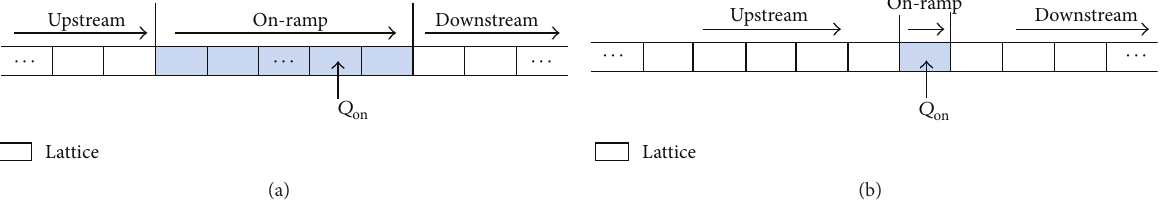
Figure 3: The sketches of the on-ramp systems. (a) The stochastic on-ramp, (b) the deterministic on-ramp.